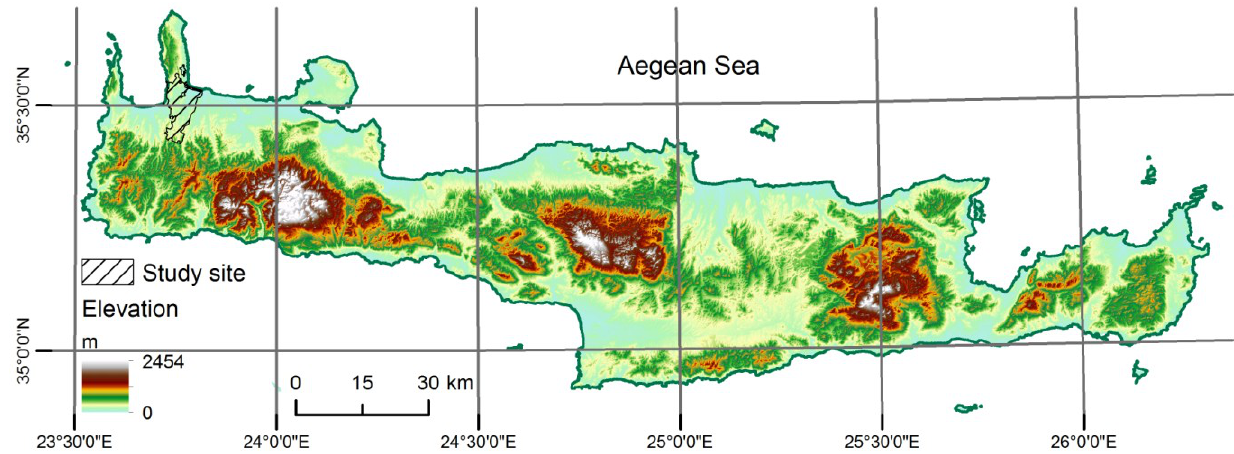
Figure 1. The agricultural area of Kolymvari,